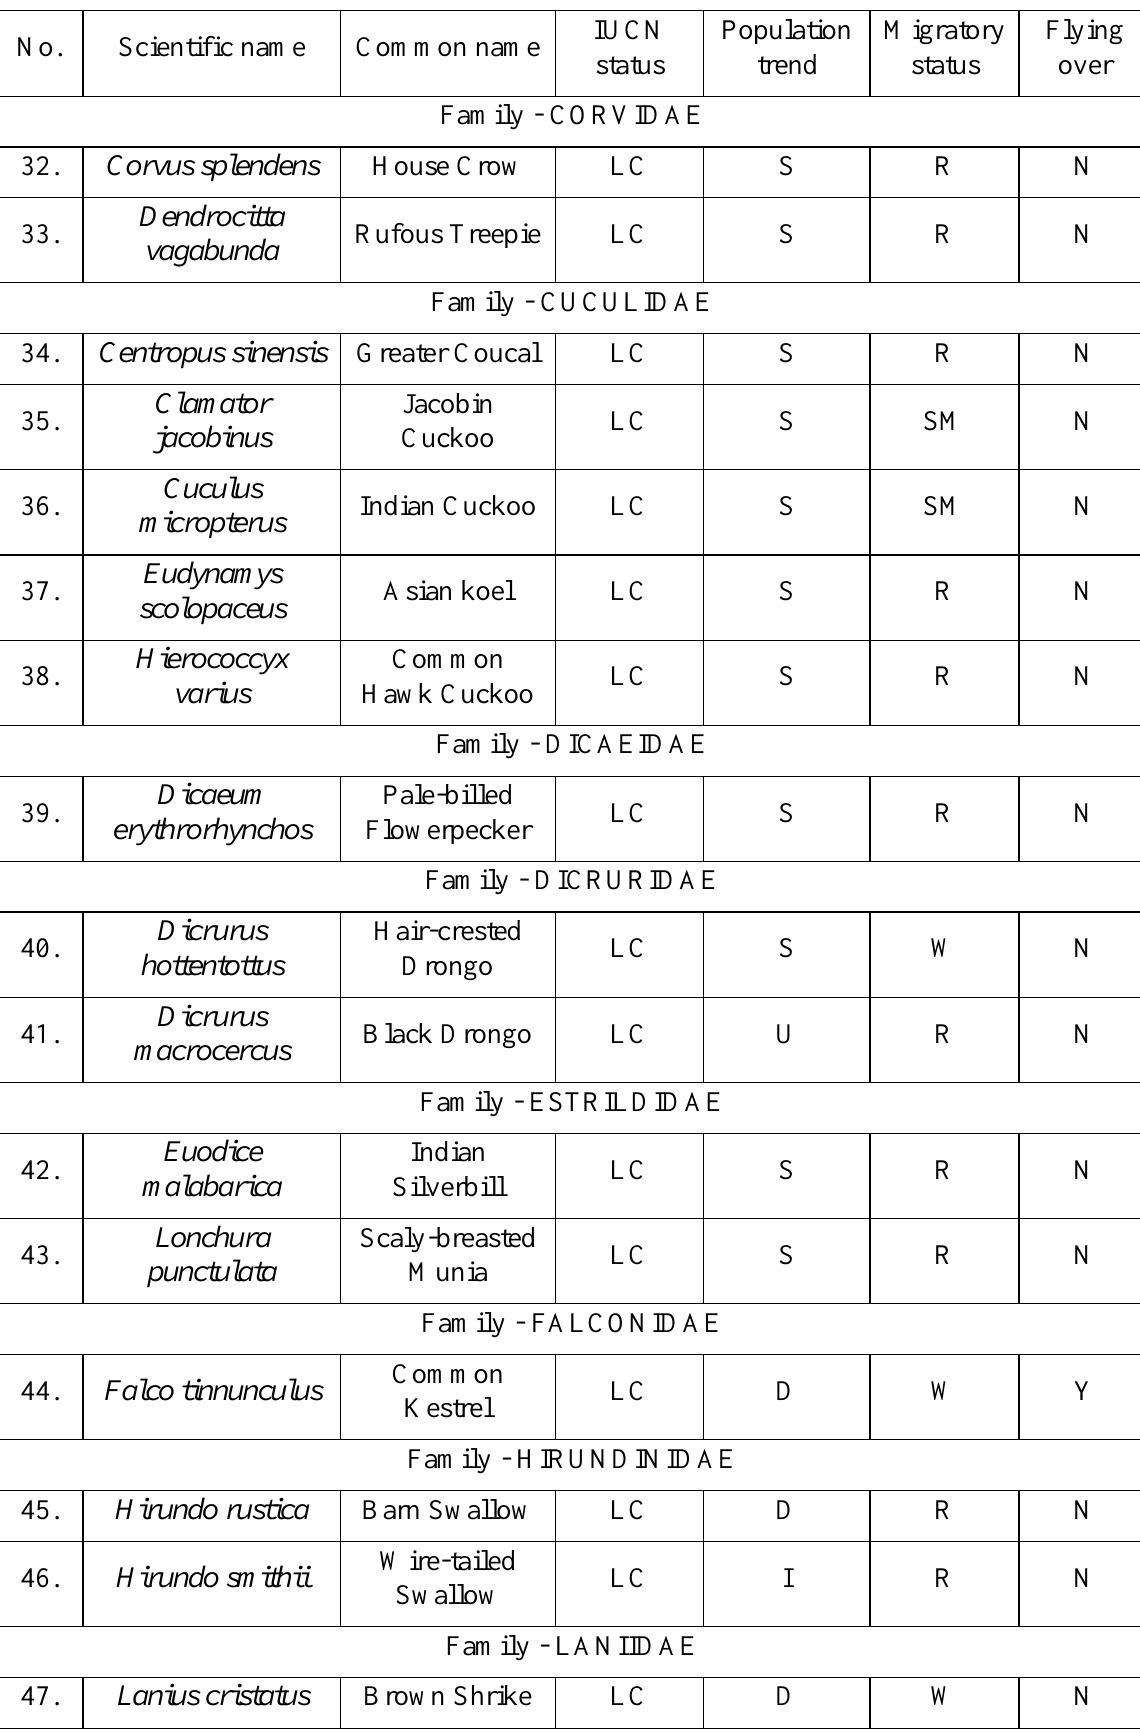
Table 1. List of bird species recorded in Durgapur Government College Campus